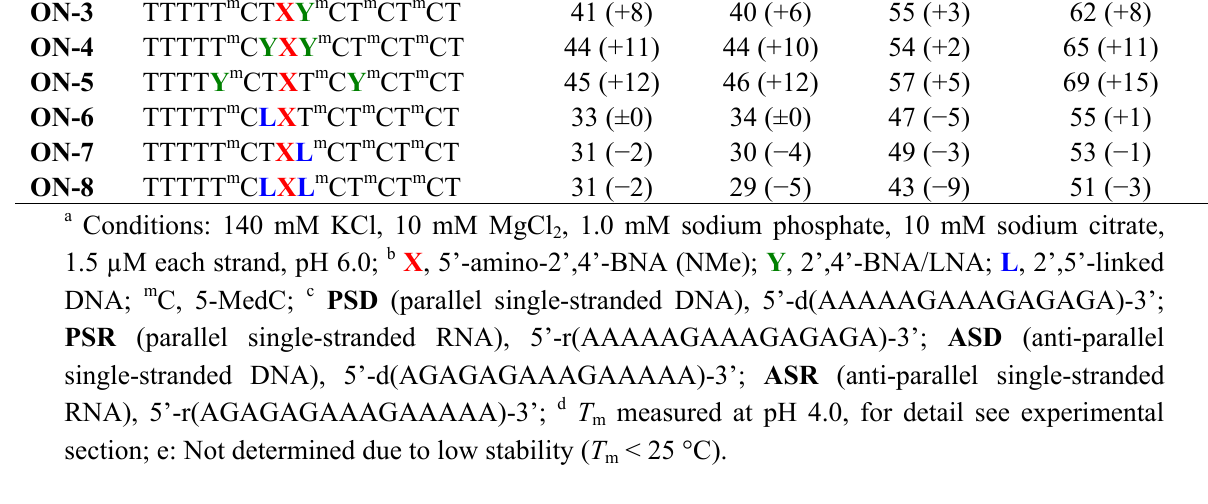
Figure 3. Melting profiles of ON-5 (left) and ON-7 (right) with PSD (red, solid), PSR (red, dashed), ASD (blue, solid), and ASR (blue, dashed). Conditions: 140 mM KCl, , 1.0 mM sodium phosphate, 10 mM sodium citrate buffer, 1.5 µM each 10 mM MgCl 2 strand, pH